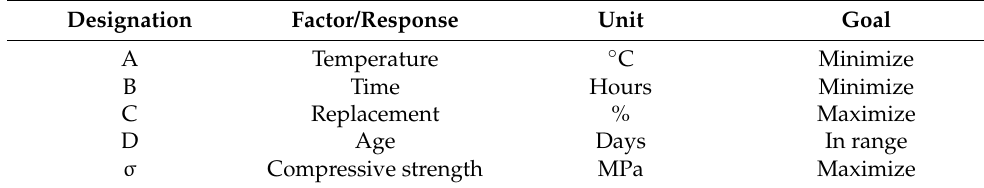
Table 1. Criteria settings for optimization.